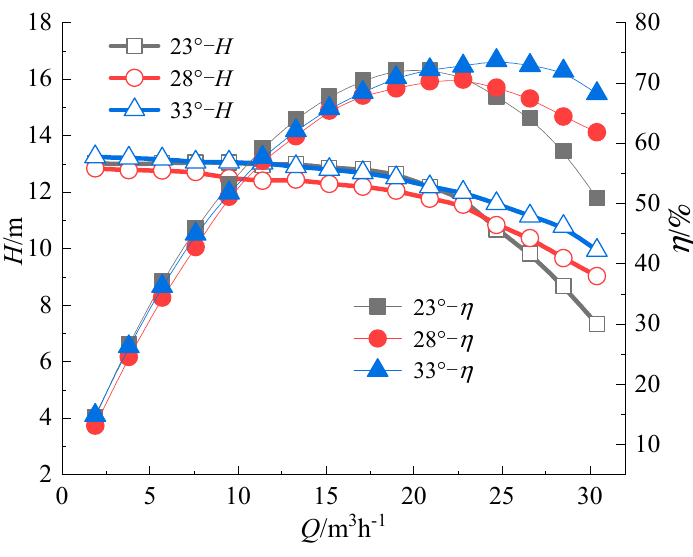
Figure 13. Performance curves with different volutes.